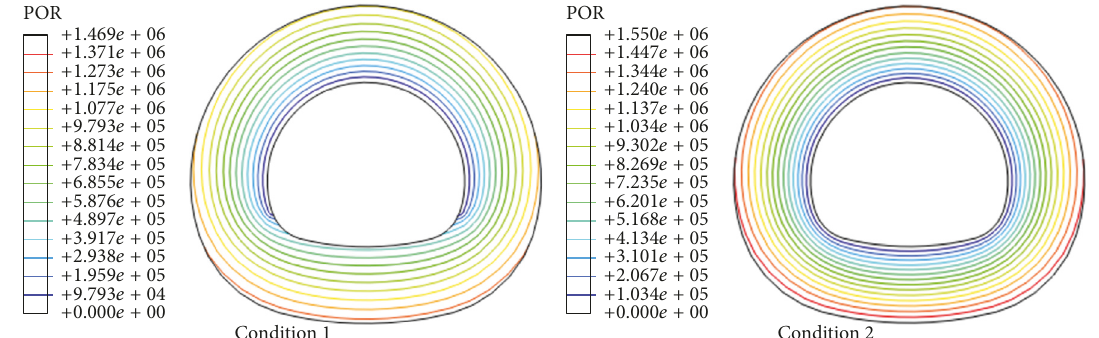
Figure 8: Contour map of pore water pressure in the 5 m range of tunnel excavation.